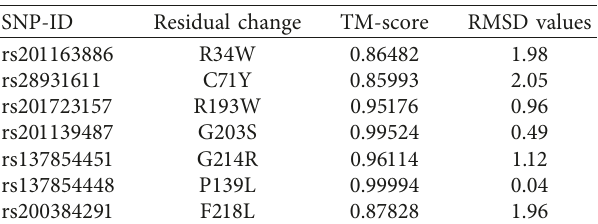
Figure 8: (a) Wild-type ELANE protein structure. (b) Superimposed structure of ELANE and its C71R mutant. (c) Superimposed structure of ELANE and its F218L mutant. (d) Superimposed structure of ELANE and its R34W mutant. (e) Superimposed structure of ELANE and its G214R mutant. Table 3: TM-score and RMSD values of 7 selected damaging nsSNPs in ELANE